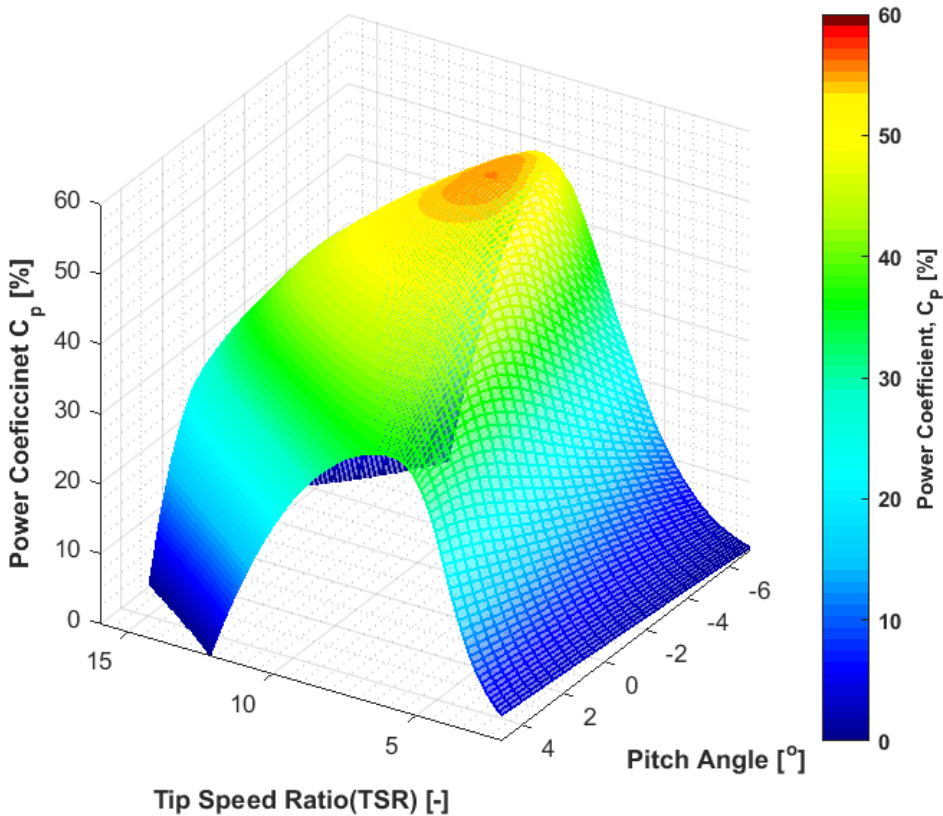
Figure 15. Power coefficient against tip speed ratio and pitch angles at design conditions.